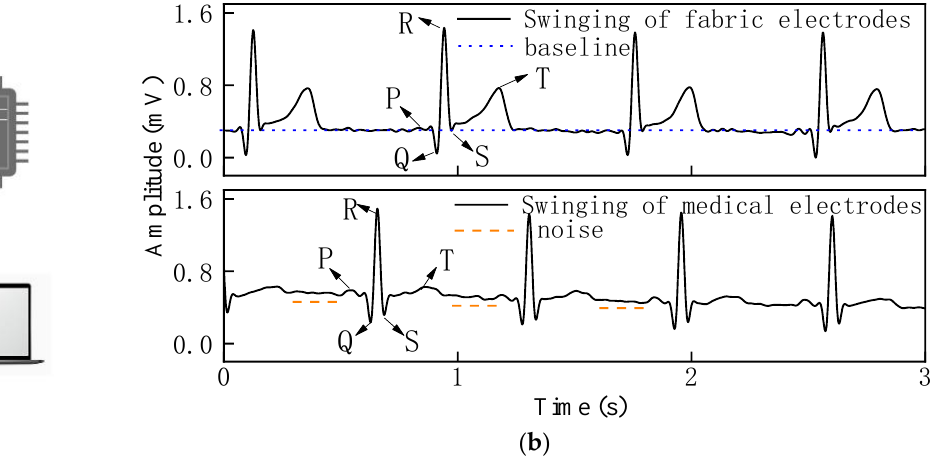
Figure 8. ( a ) Process of measuring ECG signal in swinging state. ( b ) ECG signal of woven fabric electrodes and standard medical electrodes in swinging state.